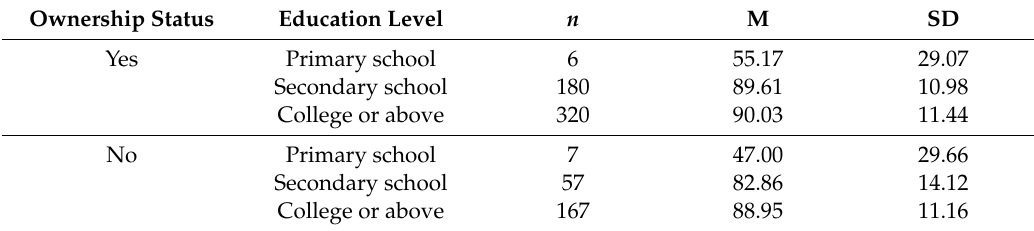
Table 8. Comparison of physical, psychological and social well-being between dog owners and non- dog owners. Variables